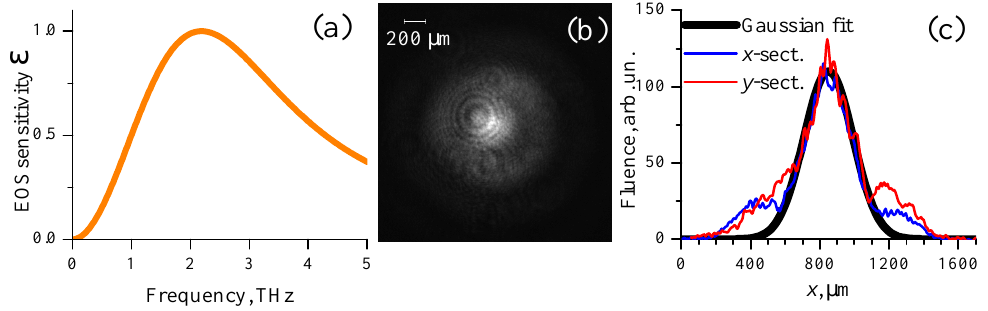
Figure 5. ( a ) Sensitivity of EOS calculated from Equation (A11) assuming Gaussian spatial distribution of the probe beam, exp [ − r 2 / ( 200 µ m ) 2 ] . ( b ) Spatial fluence distribution of the probe beam on the ZnTe crystal measured by CCD. ( c ) Cross-sections of the probe beam and the Gaussian fit of its most-intense